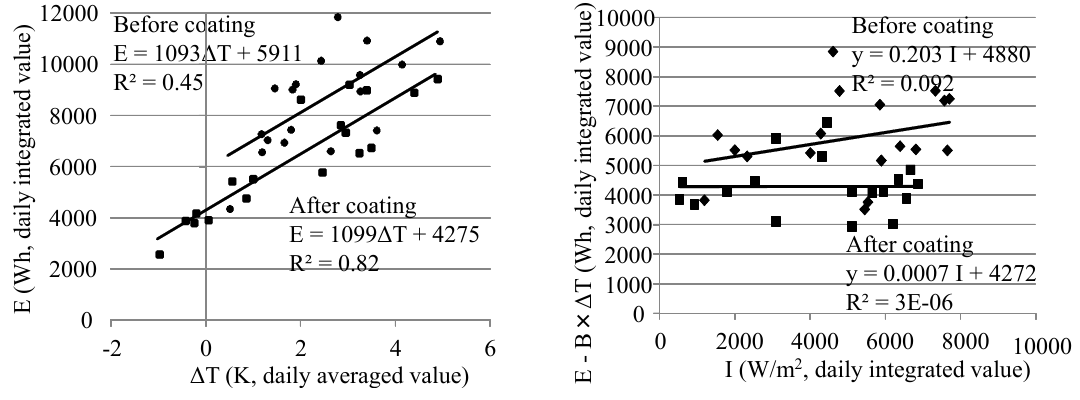
Figure 6. Relationship between (1) daily averaged outdoor-to-room air temperature difference and daily integrated cooling power consumption ( left ) and (2) daily integrated solar radiation and cooling consumption ( right